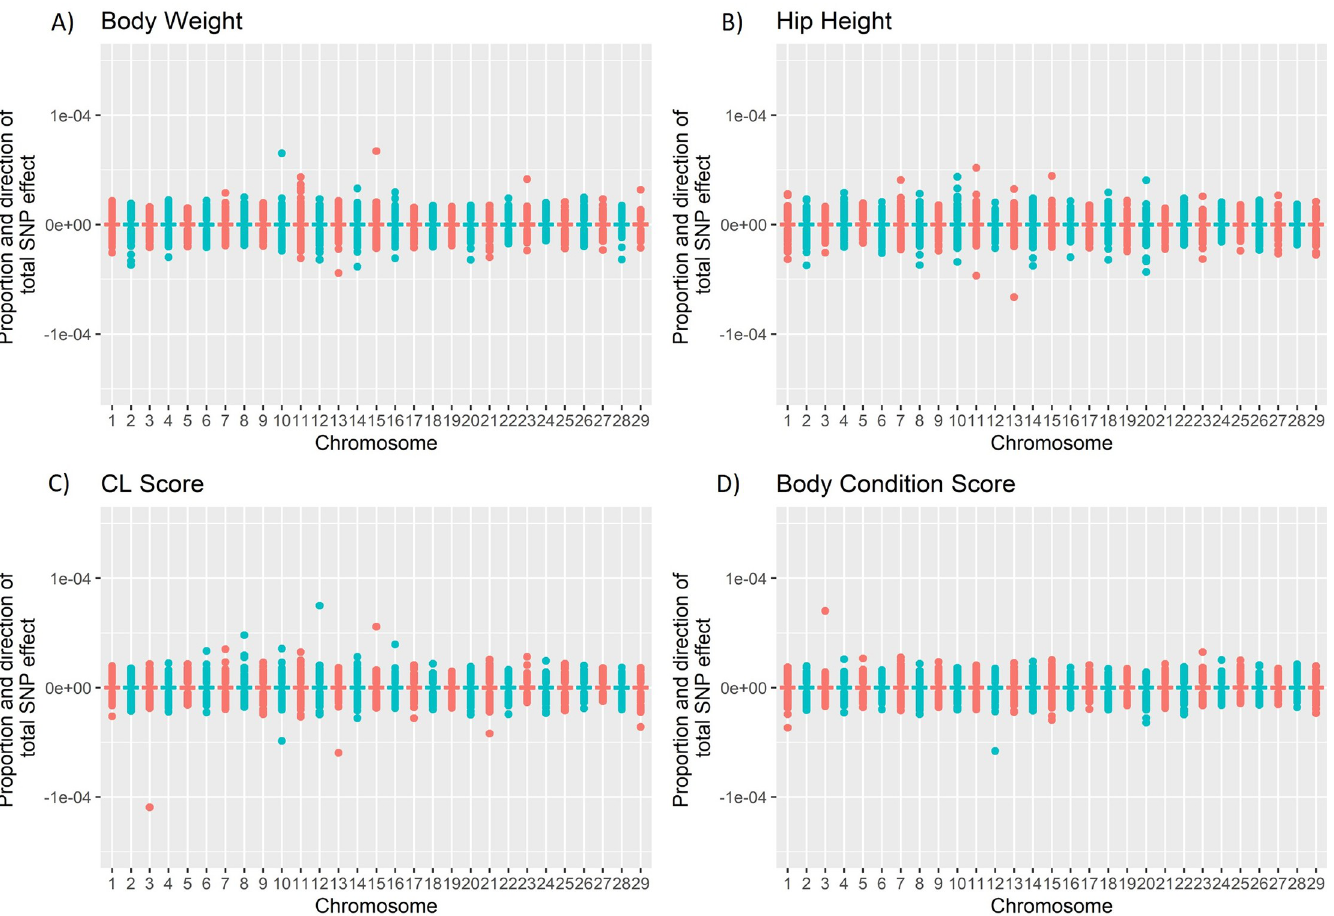
Fig 2. Proportion of total SNP effect described by each marker across the autosomes for each trait. A positive value indicates a positive directional SNP effect on the trait and a negative value, a negative directional SNP effect on the trait. The proportion of total SNP effect was calculated as E i P and ∑ | E | is the sum of the magnitudes of all markers for a particular trait. A) Body weight B) Hip Height C) CL score D) Body Condition